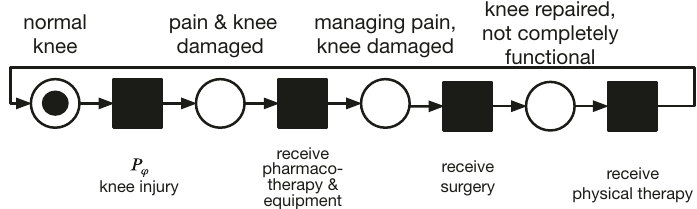
Figure 9: Acute orthopedic Individual Health Net visualizes the health state at the places (circles) and the health events, causing the changes in health state, at the transitions